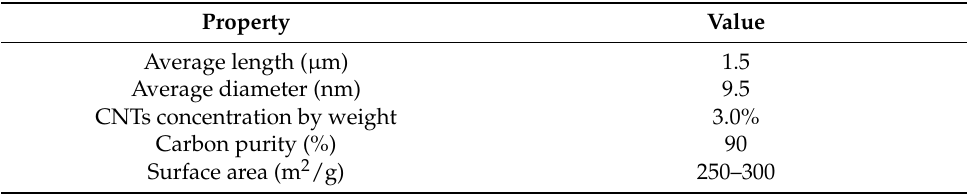
Table 2. Properties of carbon nanotubes (CNTs).